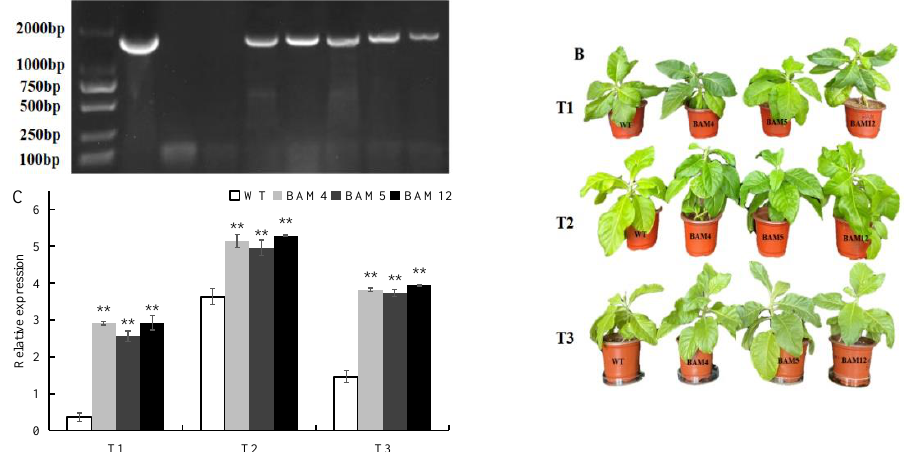
Figure 7. Cold tolerance testing of transgenic tobacco overexpressing DoBAM1 . ( A ) PCR detec- tion of DoBAM1 gene tobacco. ( B ) Phenotypes of overexpressed DoBAM1 tobacco and WT plants under control and cold treatments. ( C ) Transcript levels of DoBAM1 under different conditions. M1 = DL2000 bp DNA marker; + = plasmid pPZP221–DoBAM1 as positive control; − = water as negative control; WT = wild type; 5–9 = different transgenic lines. ** indicate a significant difference at p < 0.01 compared with WT,